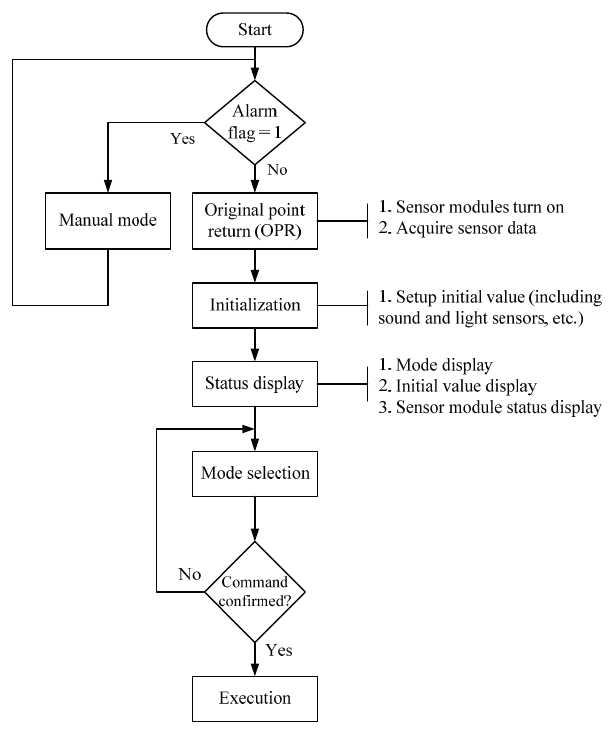
Figure 13. Main program control process.